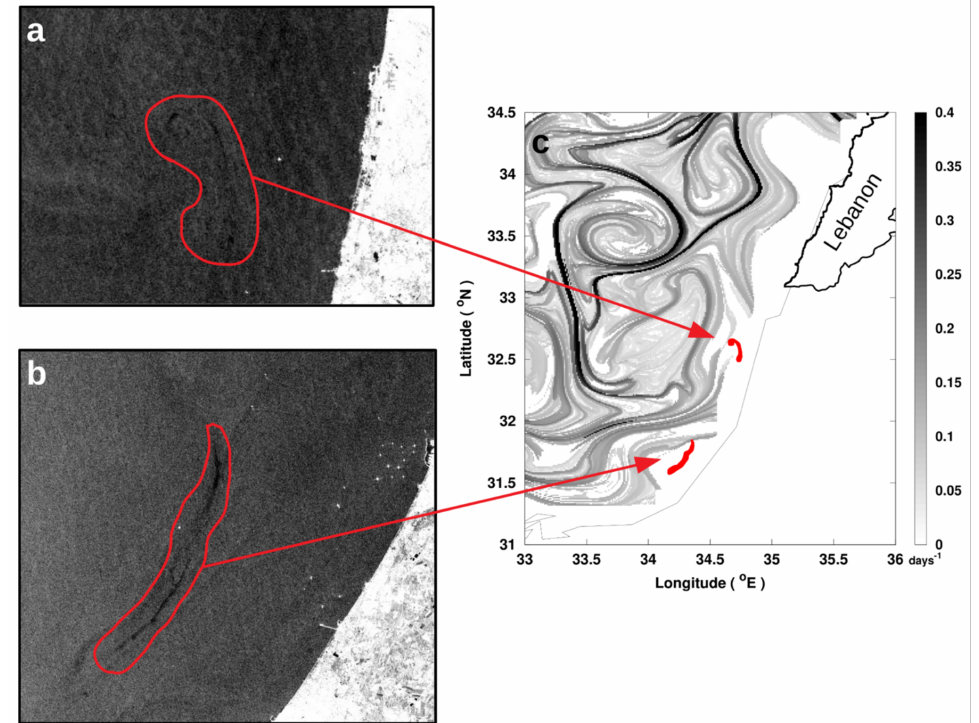
Figure 9. Altimetry-derived FSLE map of the 12th of February 2021, with the corresponding oil slicks detected by SAR images. ( a , b ) are the SAR images for two slicks of oil identified near the coast on the 12th of February provided by Sentinel-1. The FSLE map in ( c ) highlights the Lagrangian fronts in near-real-time in the southeastern Levantine basin, with the oil trajectories mapped in red. For a more reliable near-shore analysis in the southeastern Mediterranean basin, we chose the data assimilating model analysis from the Mediterranean Forecast System